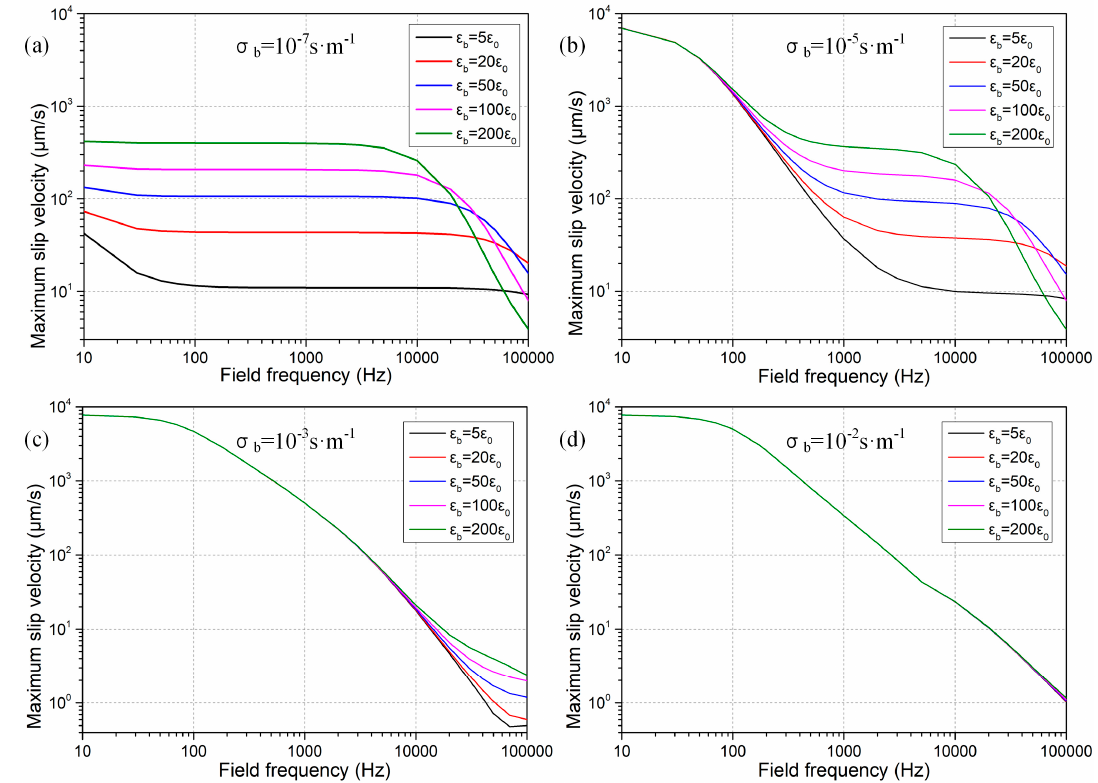
Figure 5. Effect of dielectric permittivity of leaky dielectric obstruction on the resulted ICEO flow field for a given value of liquid conductivity σ f = 10 − 3 S/m for distinct block conductivities, ( a ) σ b = 10 − 7 S/m; ( b ) σ b = 10 − 5 S/m, ( c ) σ b = 10 − 3 S/m, ( d ) σ b = 10 − 2 S/m.